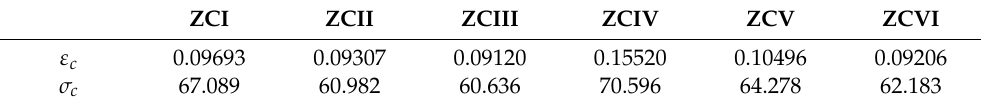
Table 6. Critical strain in experimental alloys of various compositions.